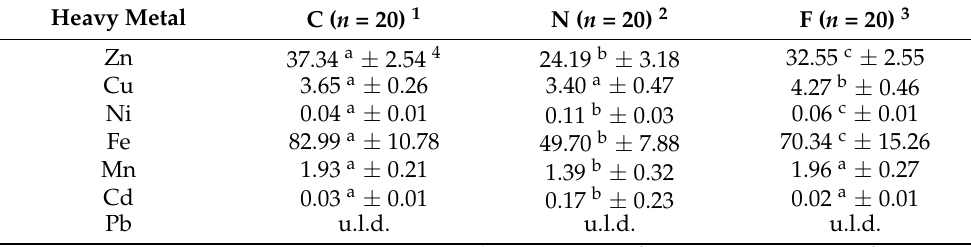
Table 3. The effect of diet on the content of selected heavy metals in rabbit liver in mg/kg (w.w.).